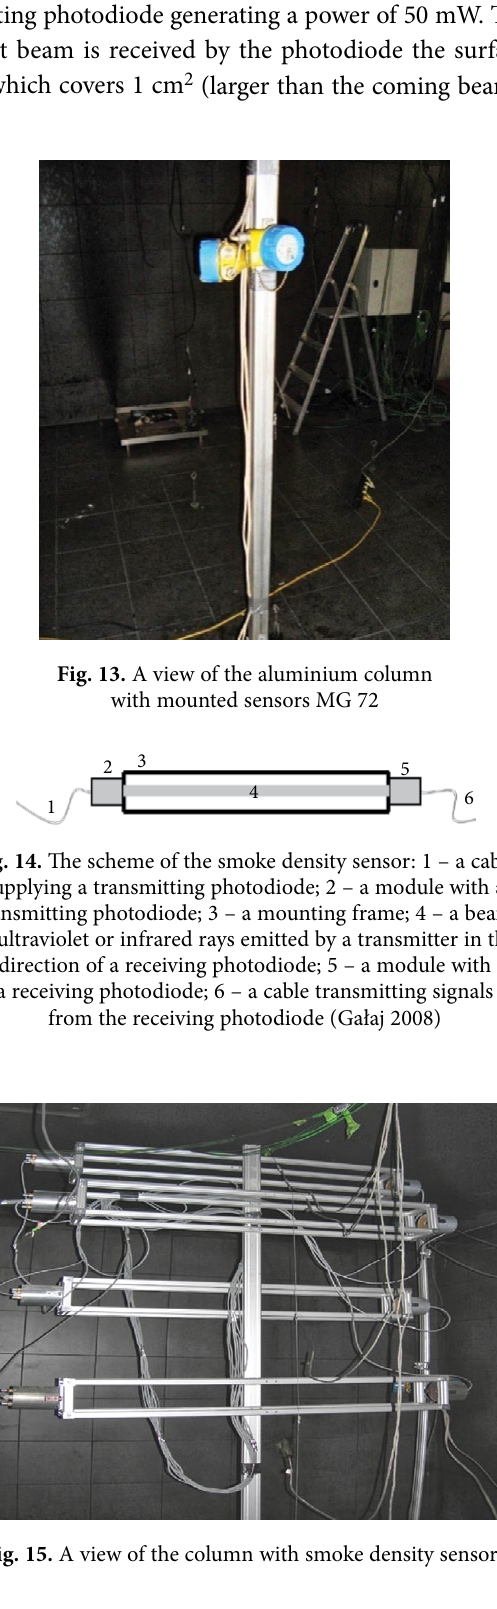
Table 6. Maximum values of extinction coefficient k in 1/m and corresponding times obtained during the initial and final combustion stages of non-treated and treated pine timber Phase of combustion Initial Final